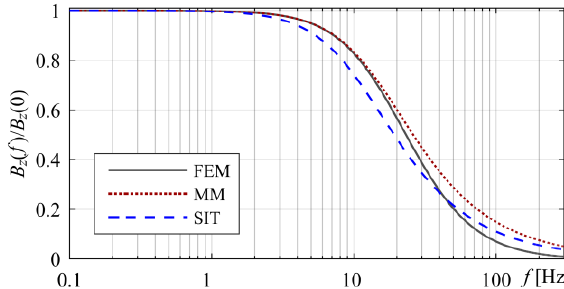
Fig. 3. MT1 model matching error.